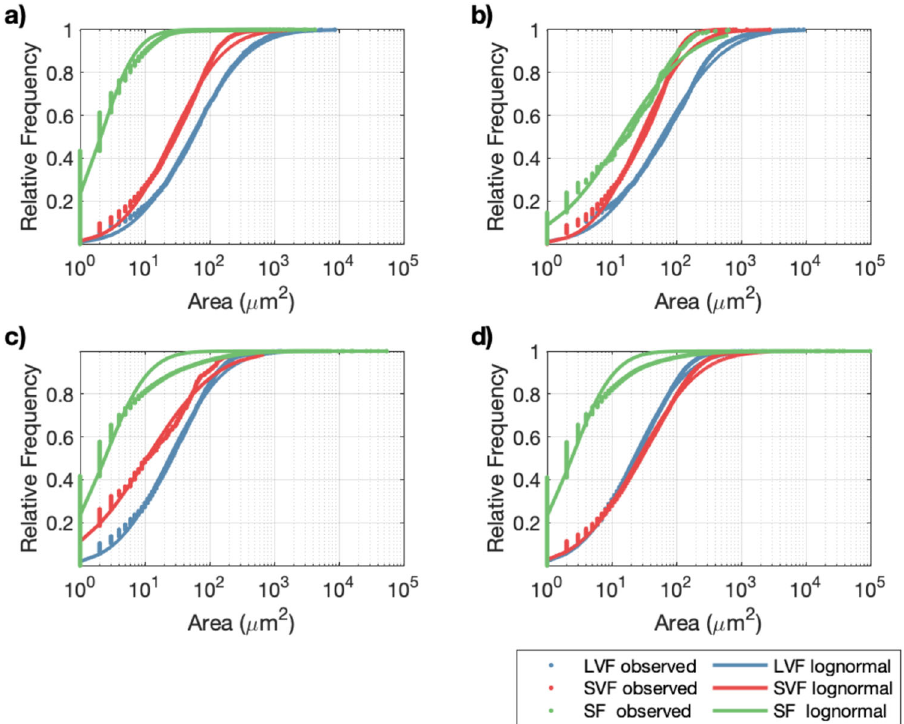
Fig. 6 Cumulative frequency distributions of the area covered by individual clumps when imaged by a microscope in experiment set 1 at the end of 4 weeks. a bio fi lm (cells) on slides in the middle section of the channel. b EPS only on slides in the middle section of the channel. c bio fi lm on paper through which samples of the channel ef fl uent was fi ltered. d EPS only on paper through which samples of the channel ef fl uent was fi